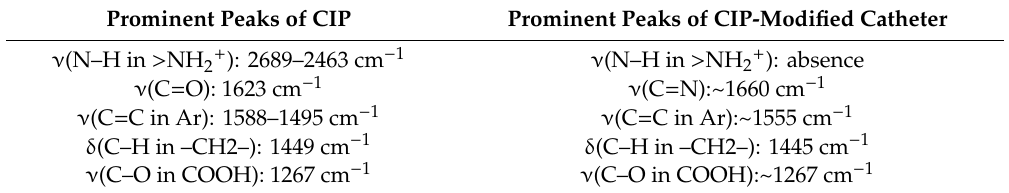
Table 4. Summary of FTIR analysis of the CIP-modified catheter following the CIP-M1 method. Prominent Peaks of CIP Prominent Peaks of CIP-Modified Catheter